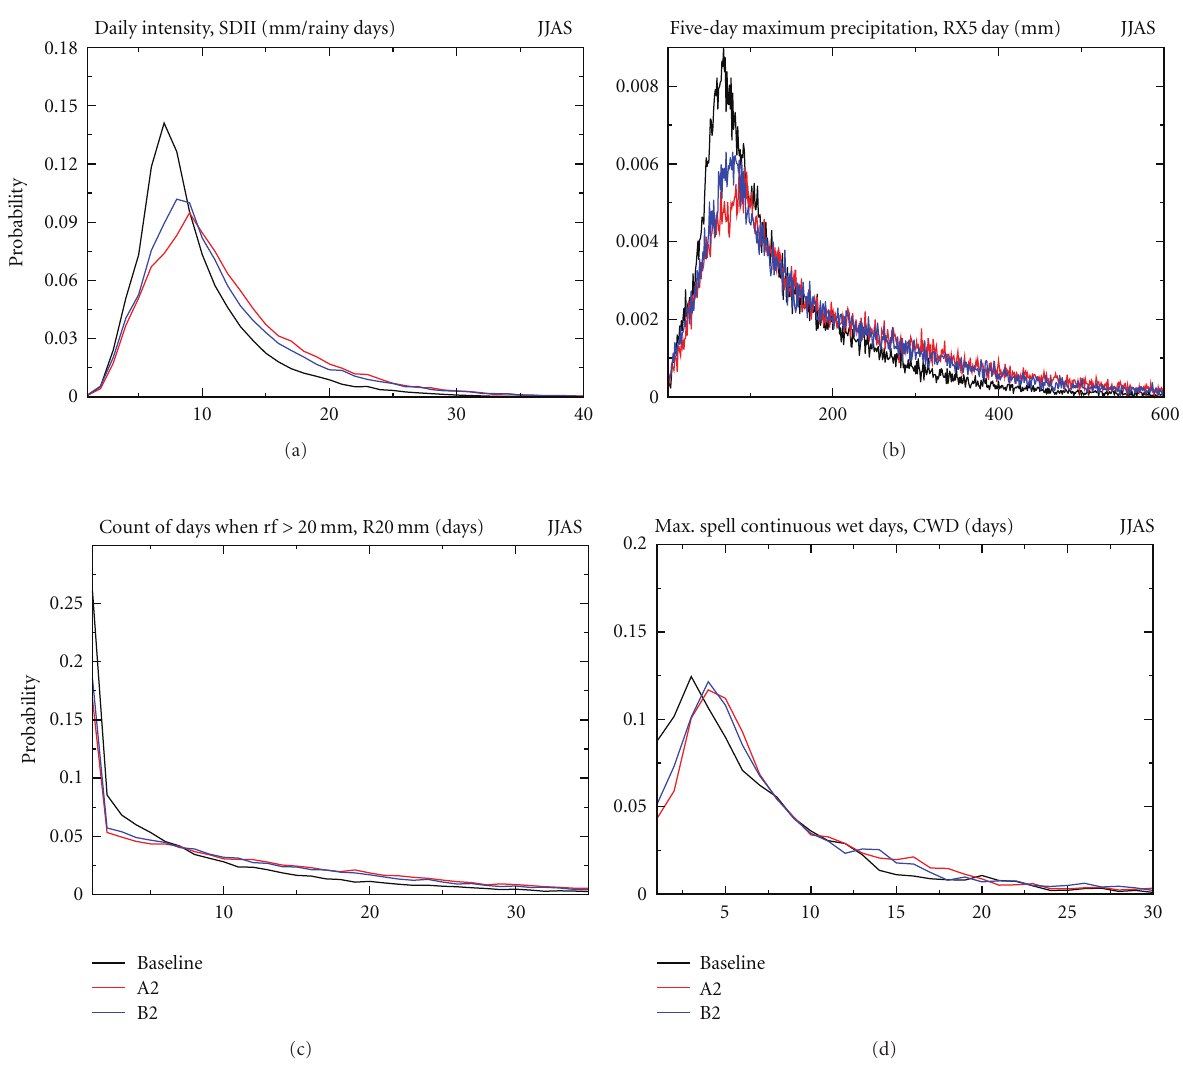
Figure 5: Probability distribution function of daily intensity, SDII ((a), mm/rainy days); five-day maximum precipitation, RX5day ((b), mm); count of days when rf > 20mm, R20 mm ((c), days) and maximum spell of continuous wet days, CWD, ((d), days). For baseline (1961–1990), A2 and B2 scenarios (2071–2100) during Indian summer monsoon season (JJAS).